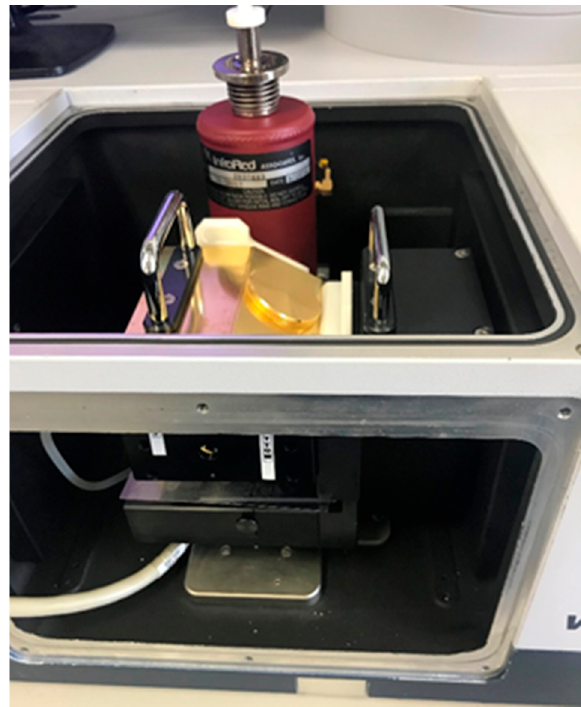
Figure A12. The Bruker integrating sphere and MCT detector in the Bruker VERTEX 80v sample compartment at CSIRO.